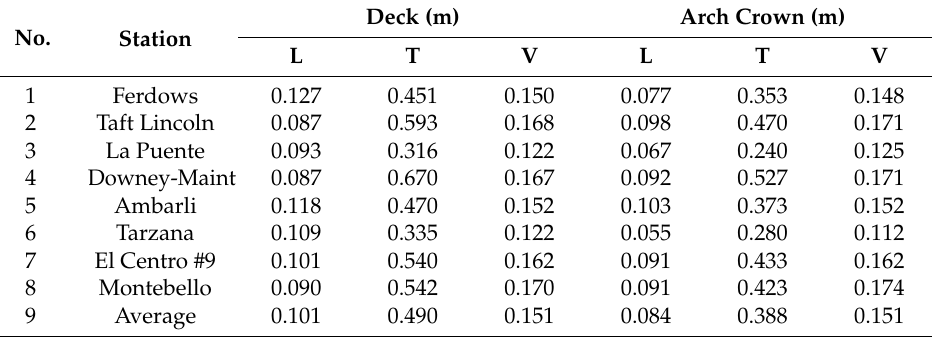
Table 5. Maximum displacement values at deck and arch crown for far-field